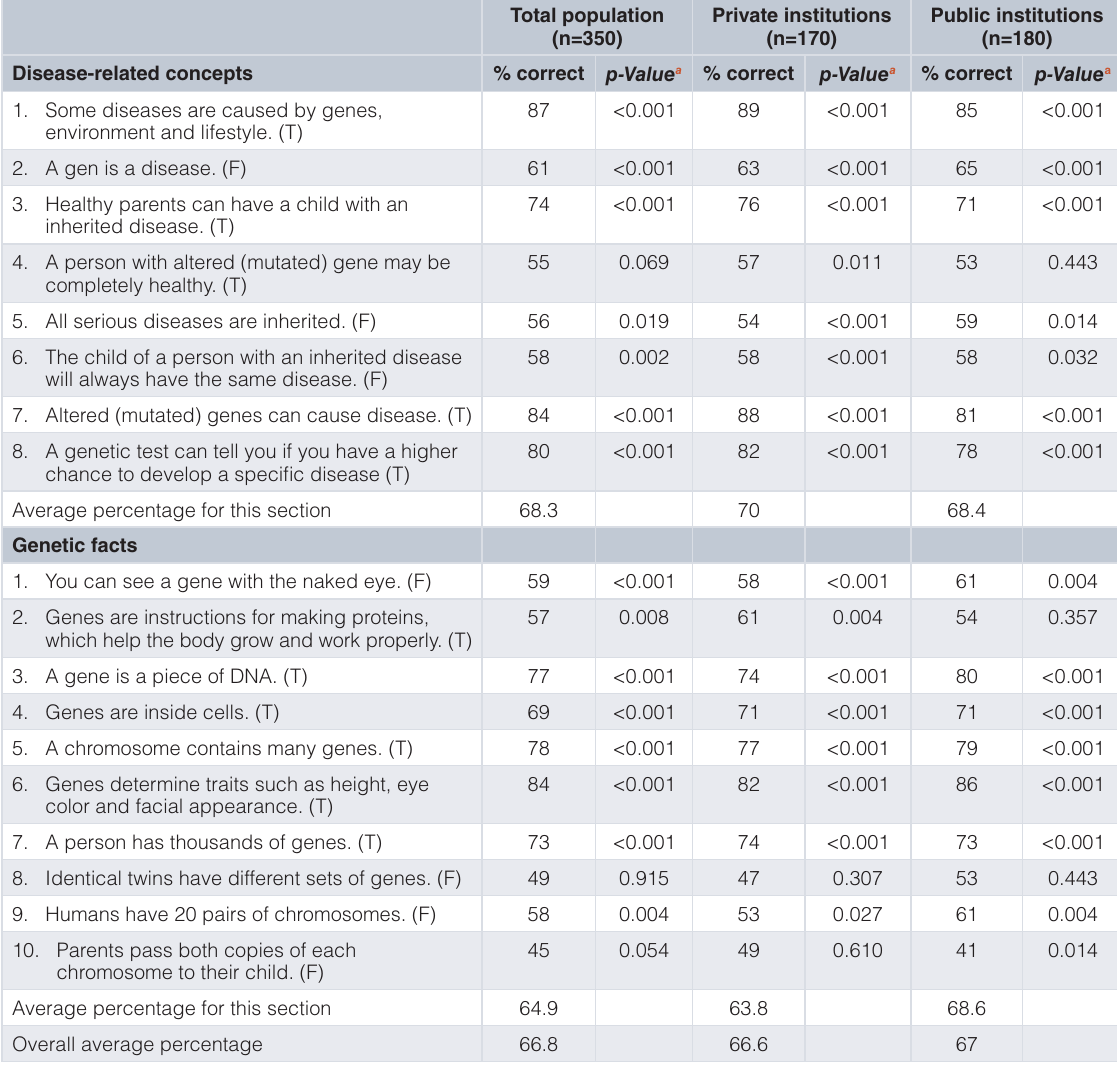
Table 1. Knowledge of disease related-concepts and genetic facts of undergraduate students with percentages of correct